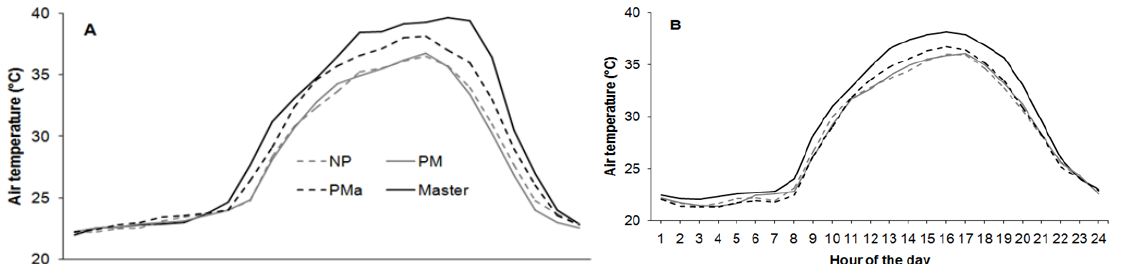
Figure 5. Daily cycle of air temperature (max) (°C) at the two vineyards A (Ponte Piave) and B (San Nicolò) in the three field treatments applied: NP, no pruning (gray dotted line); PM mechanical pruning (gray solid line); PMa manual pruning (black dotted line). Master (black solid line) is the air temperature measured outside the vineyard. All the values are hourly averages of two years of observations from April to